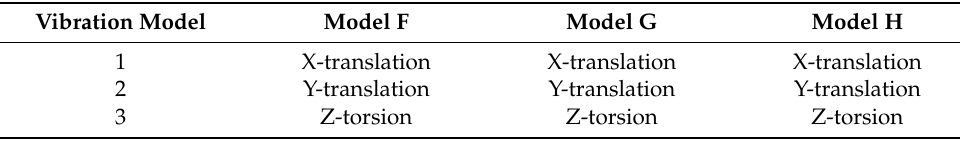
Table 14. The direction of the first three modes of the models.